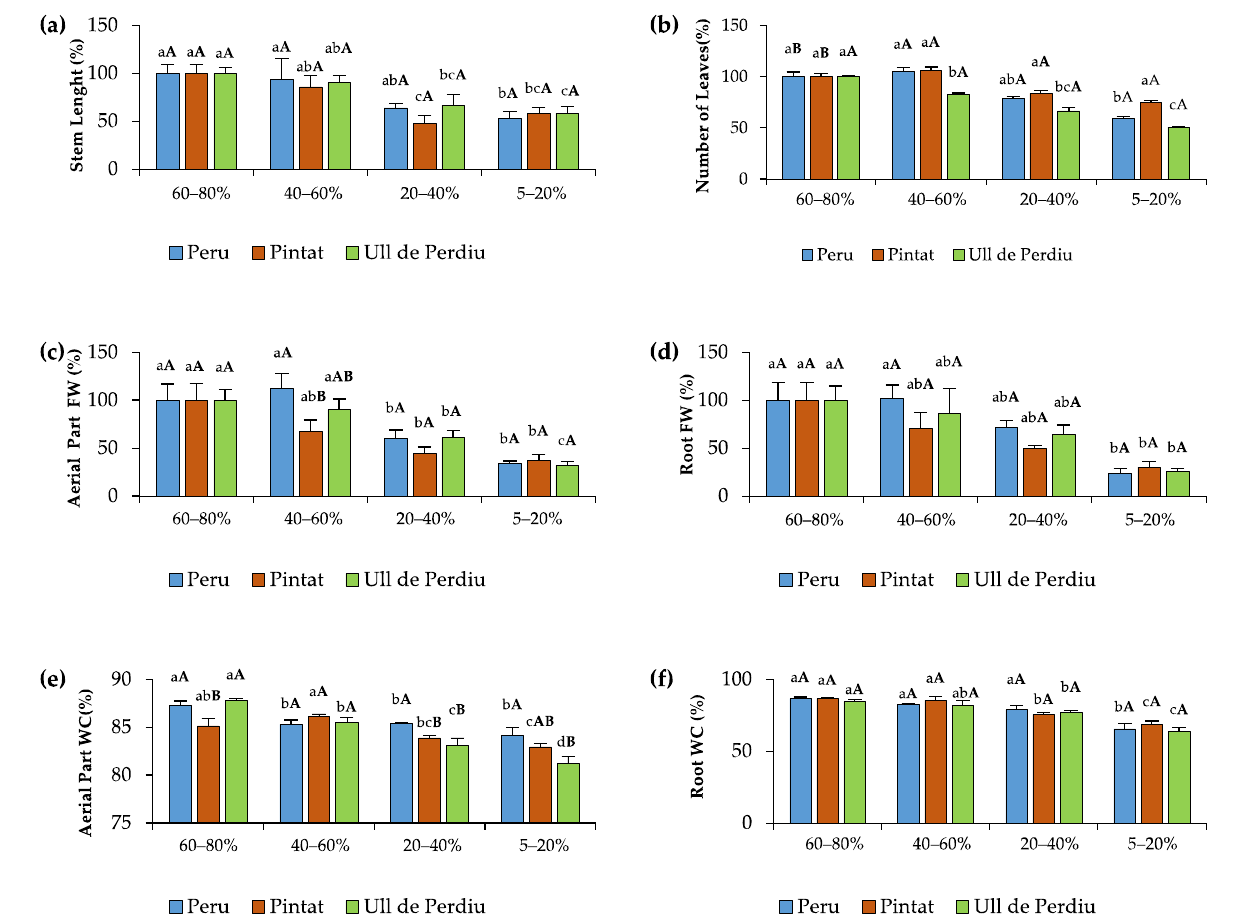
Figure 2. Effect of water stress on plant growth parameters of the three Phaseolus lunatus cultivars expressed as percentage reduction with respect to their respective control (60–80% of soil moisture), where FW is ‘fresh weight’ and WC ‘water content’: stem length ( a ), number of leaves ( b ), aerial part FW ( c ), root FW ( d ), aerial part WC ( e ) and root WC ( f ). Absolute values stem length, Peru: 5.55 cm, Pintat: 5.82 cm and Ull de Perdiu: 5.51 cm. Absolute values number of leaves: Peru: 24.8, Pintat 26 and Ull de Perdiu: 36.4. Absolute values FW aerial part: Peru: 52.45 gr, Pintat: 67.23 gr and Ull de Perdiu: 60.33 gr. Absolute values FW roots: Peru: 11.40 gr, Pintat: 17.21 gr and Ull de Perdiu: 12.71 gr. Lowercase letters indicate significant differences within each cultivar and uppercase letters (in bold) between cultivars, but within treatments, according to Tukey’s test ( α = 0.05). p values according to one-way ANOVA.